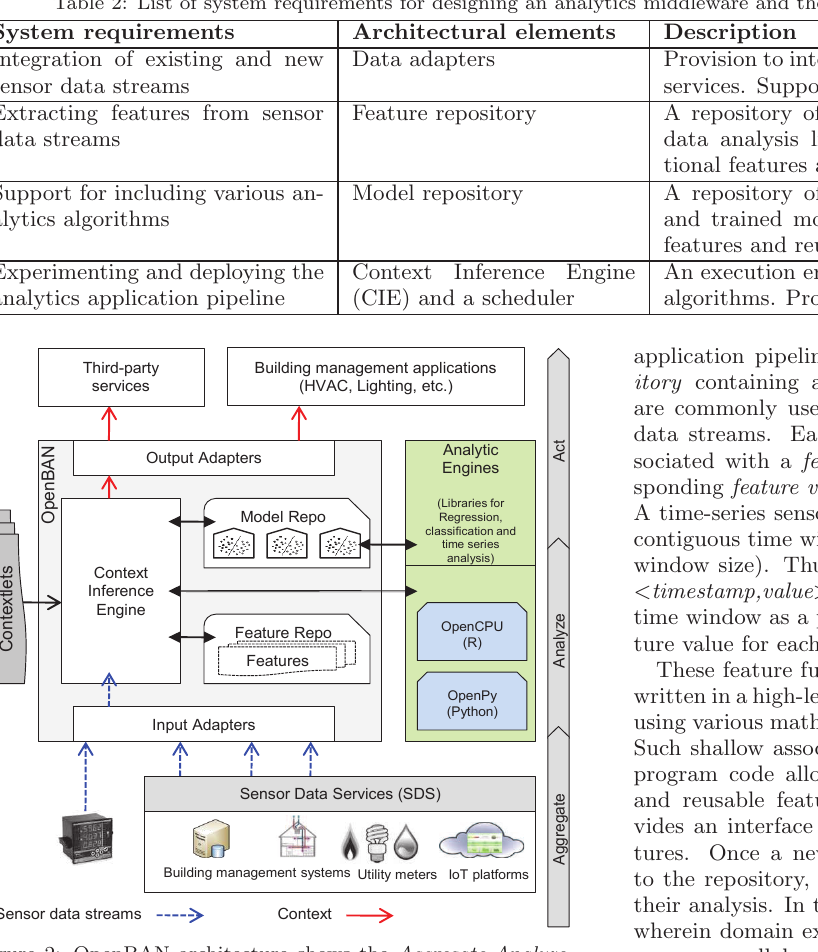
Figure 2: OpenBAN architecture shows the Aggregate-Analyze- Act pipeline of building management application. It integrates multiple sensor data streams, and computes the required context information in real time which can be used by multiple energy management